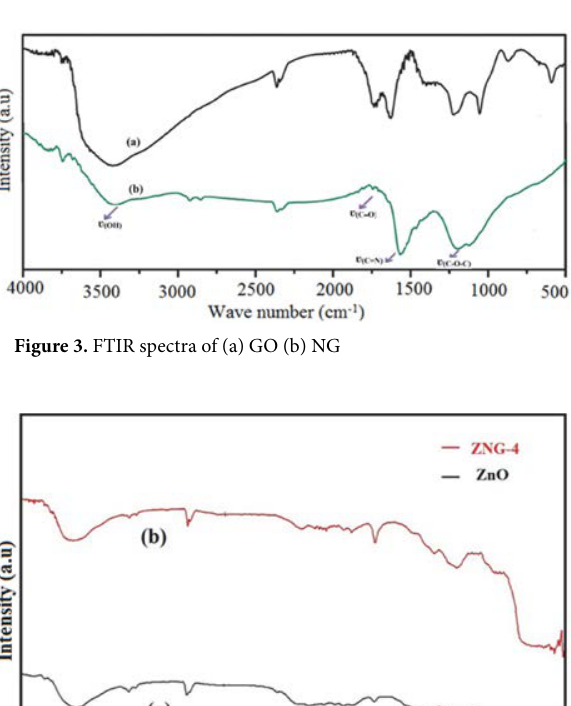
Figure 5. Raman spectrum of (a) NG (b) ZNG-4. der and hybridization caused by heteroatom (nitrogen/ oxygen) doping and structure defects. Therefore, the rela- tively increased intensity of the D band for NG indicates that the content of disordered carbon increases, particu- larly by nitrogen